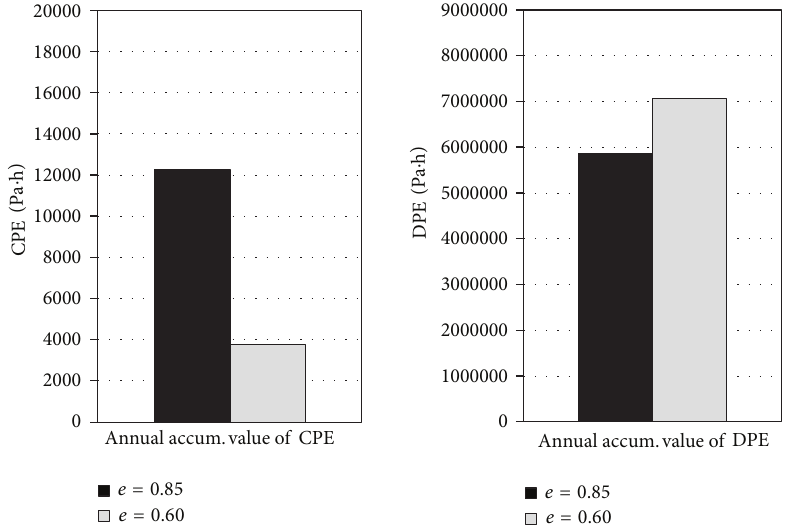
Figure 11: Properties of the exterior layer: emissivity.